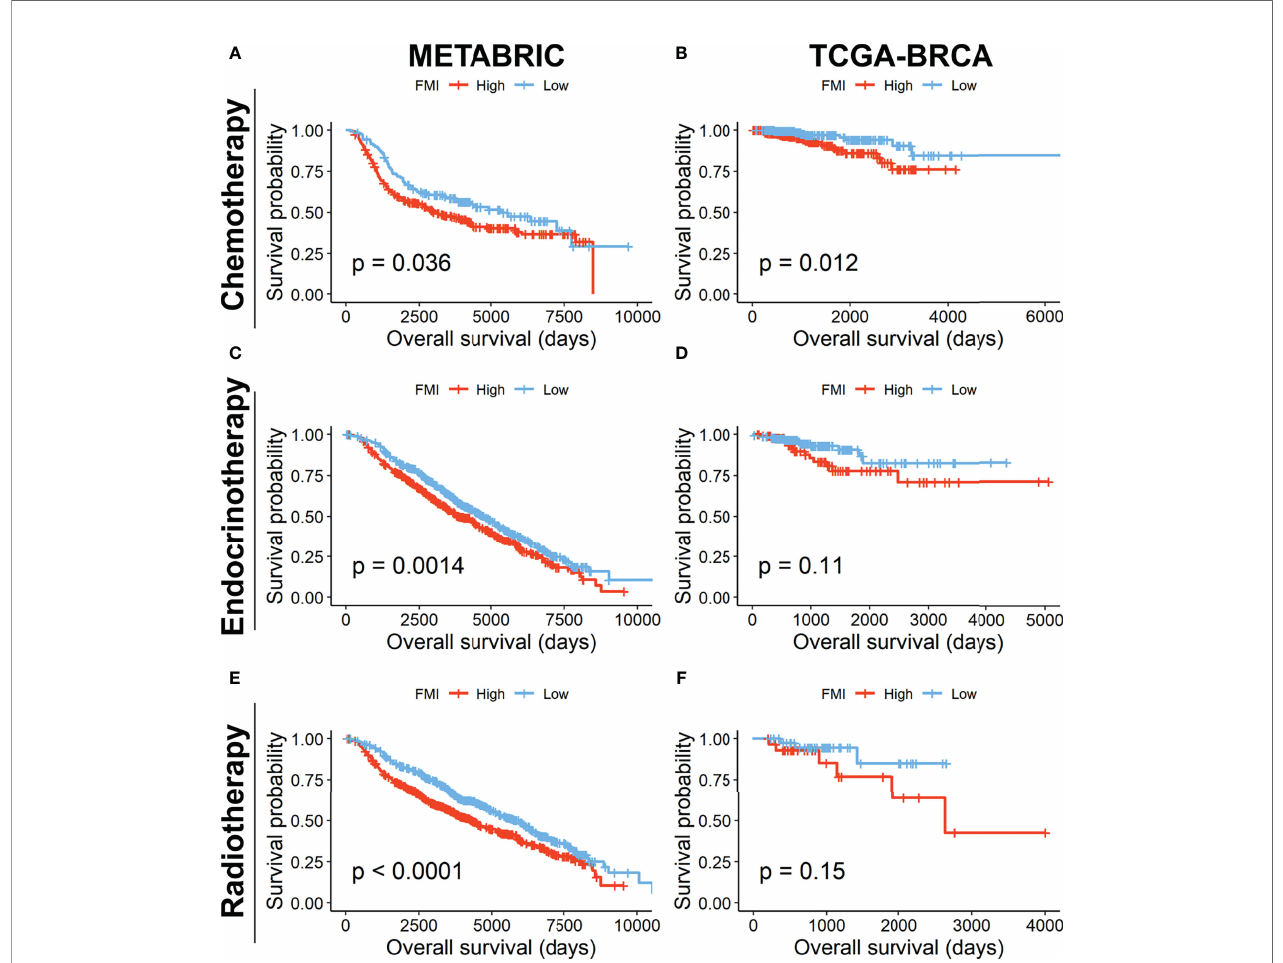
FIGURE 8 | Prognostic validation of FMI in BC patients undergoing different treatment regimens. K-M analyses of OS in BC patients undergoing chemotherapy (A, B) , endocrinotherapy (C, D) , and radiotherapy (E, F) between high- and low-FMI groups in METABRIC and TCGA-BRCA cohorts, respectively. FMI, fatty acid metabolism index; BC, breast cancer; K-M, Kaplan – Meier; OS, overall survival; METABRIC, Molecular Taxonomy of Breast Cancer International Consortium; TCGA, The Cancer Genome